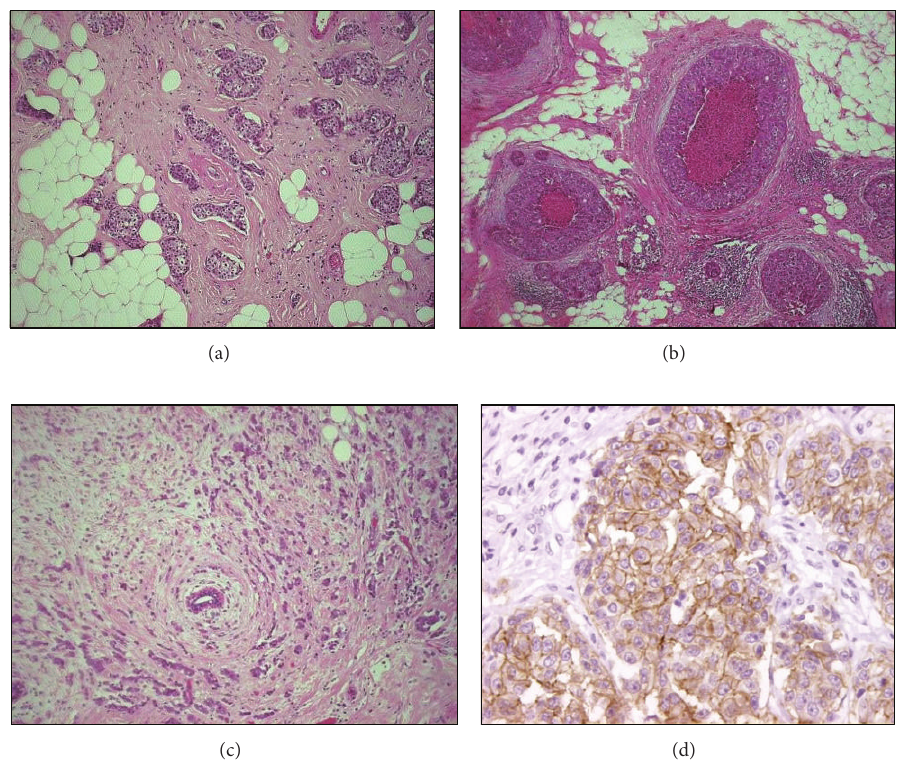
Figure 1: Histological images of breast carcinoma. Images of (a) ductal carcinoma no special type (NST), (b) ductal carcinoma in situ (DCIS), and (c) lobular carcinoma. (d) HercepTest positive staining: immunocytochemical staining indicates HER-2 overexpression in invasive breast cancer (Images courtesy of Dr. D. Hemming, Queen Elizabeth Hospital,